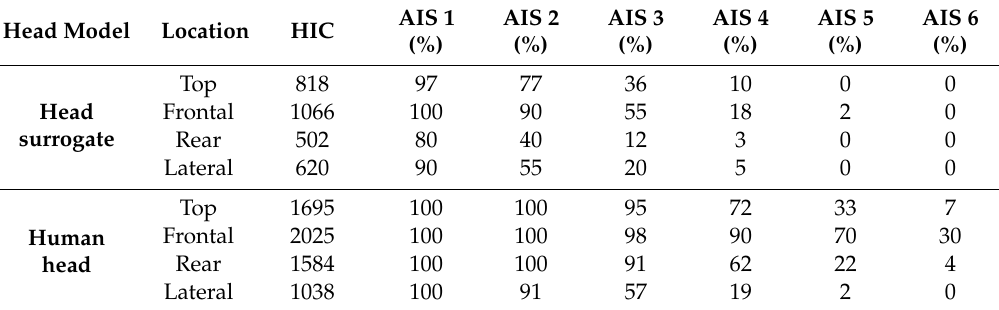
Table 9. HIC and AIS (%) for curbstone anvil case.